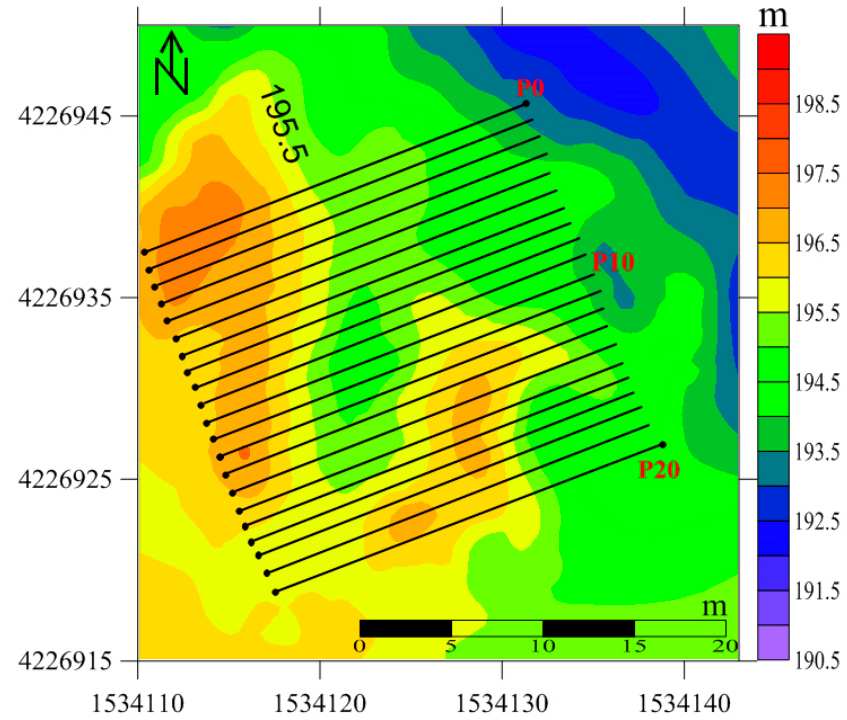
Figure 26. Induced-polarization survey performed at an archeological test site in France. A total of 21 profiles (24 electrodes each) are used to perform 3D tomograms of chargeability and electrical resistivity. The color scale represents the topography of the area (altitude in meters (m) above sea level). The present survey comprises 3150 dipole–dipole measurements. Modified from [98].